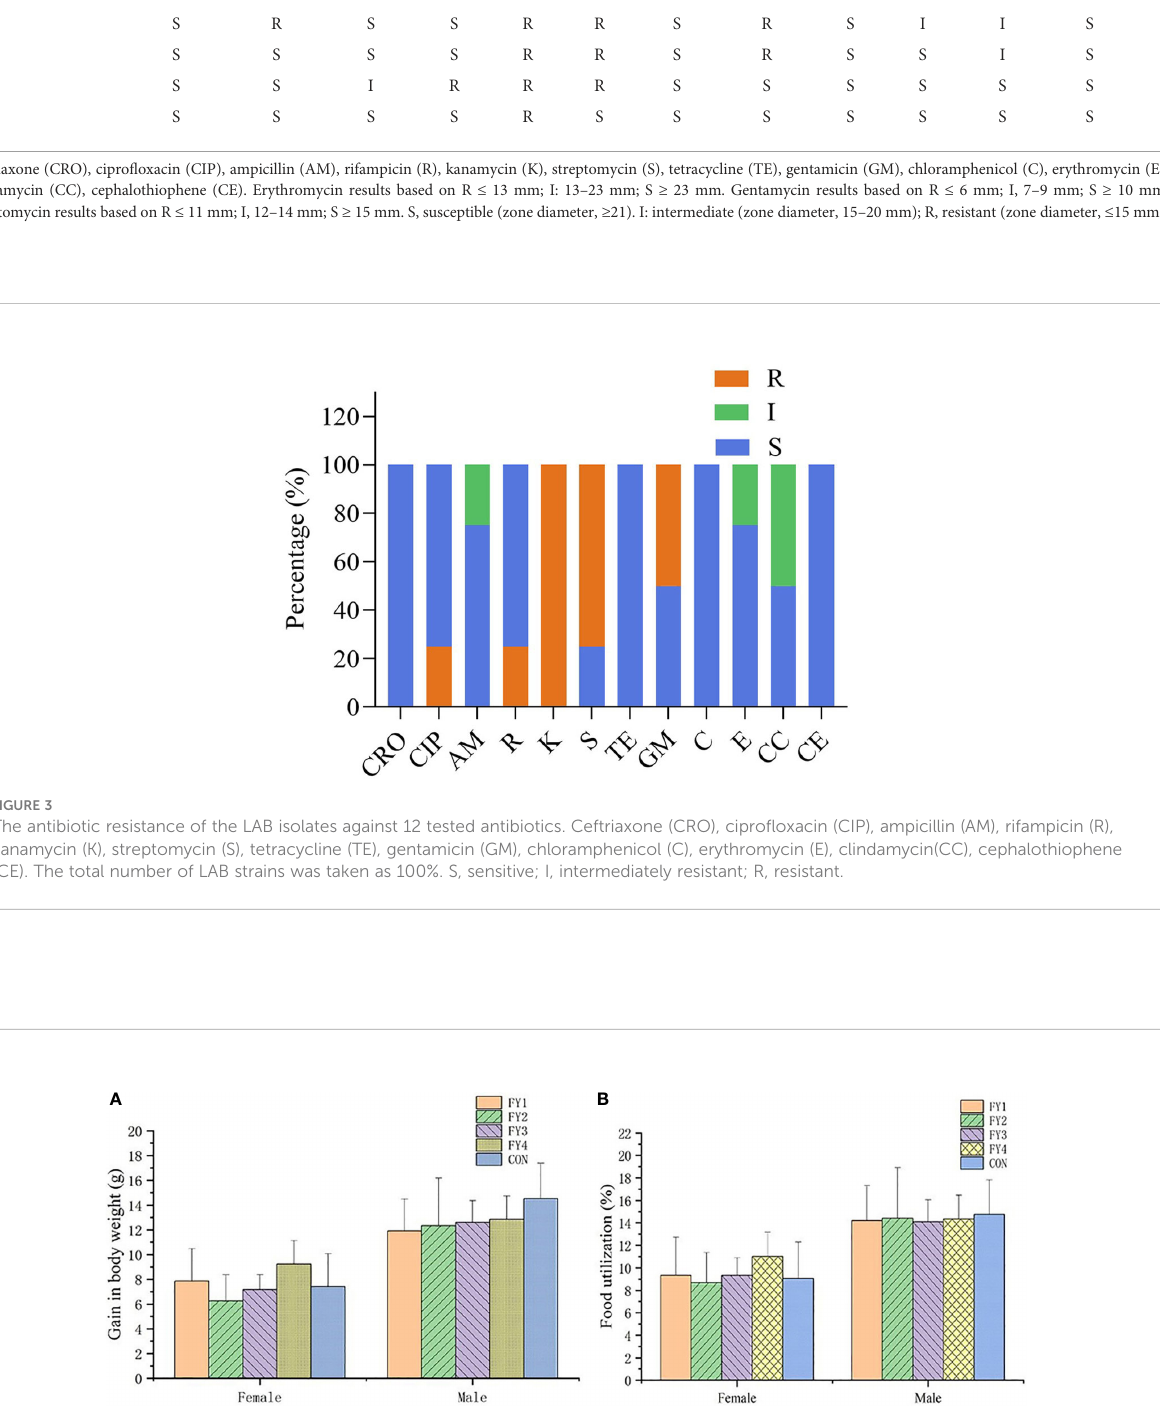
FIGURE 4 Effect of LAB on body weight gain and food utilization rate of experimental mice. (A) Body weight gain of female and male mice in each group. (B) Food utilization rate of female and male mice in each group.